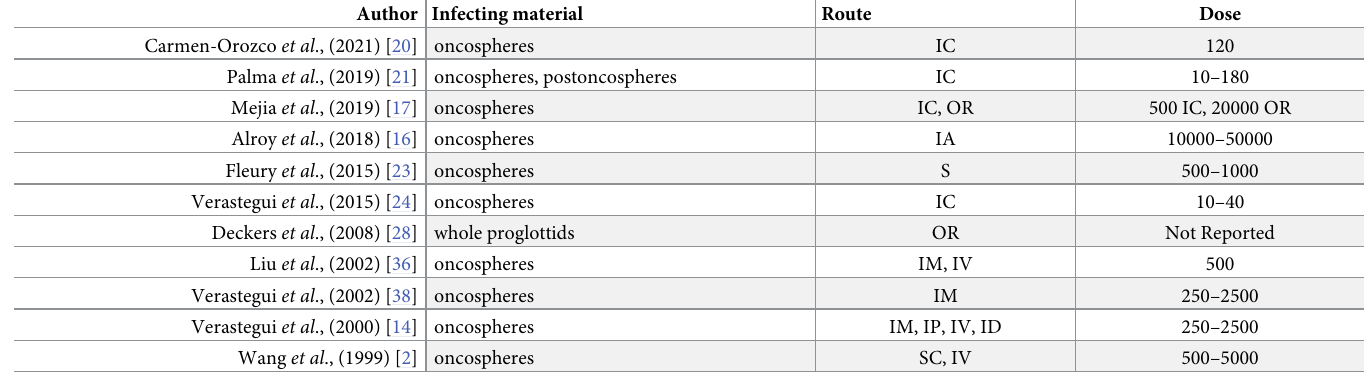
Table 5. Description of the infecting material, their dose and infection route, which includes intravenous (IV); subcutaneous (SC); intramuscular (IM); intraperito- neal (IP); intraarterial (IA); intracranial (IC); intraduodenal (ID);oral (OR) and surgical (S), used in the studies for T . solium .